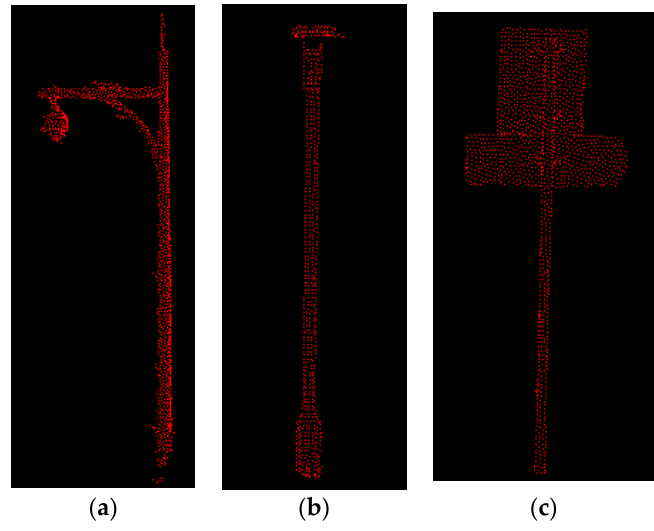
Figure 8. Different types of pole-like structures: ( a ) street lamp, ( b ) street lamp, ( c ) road sign.